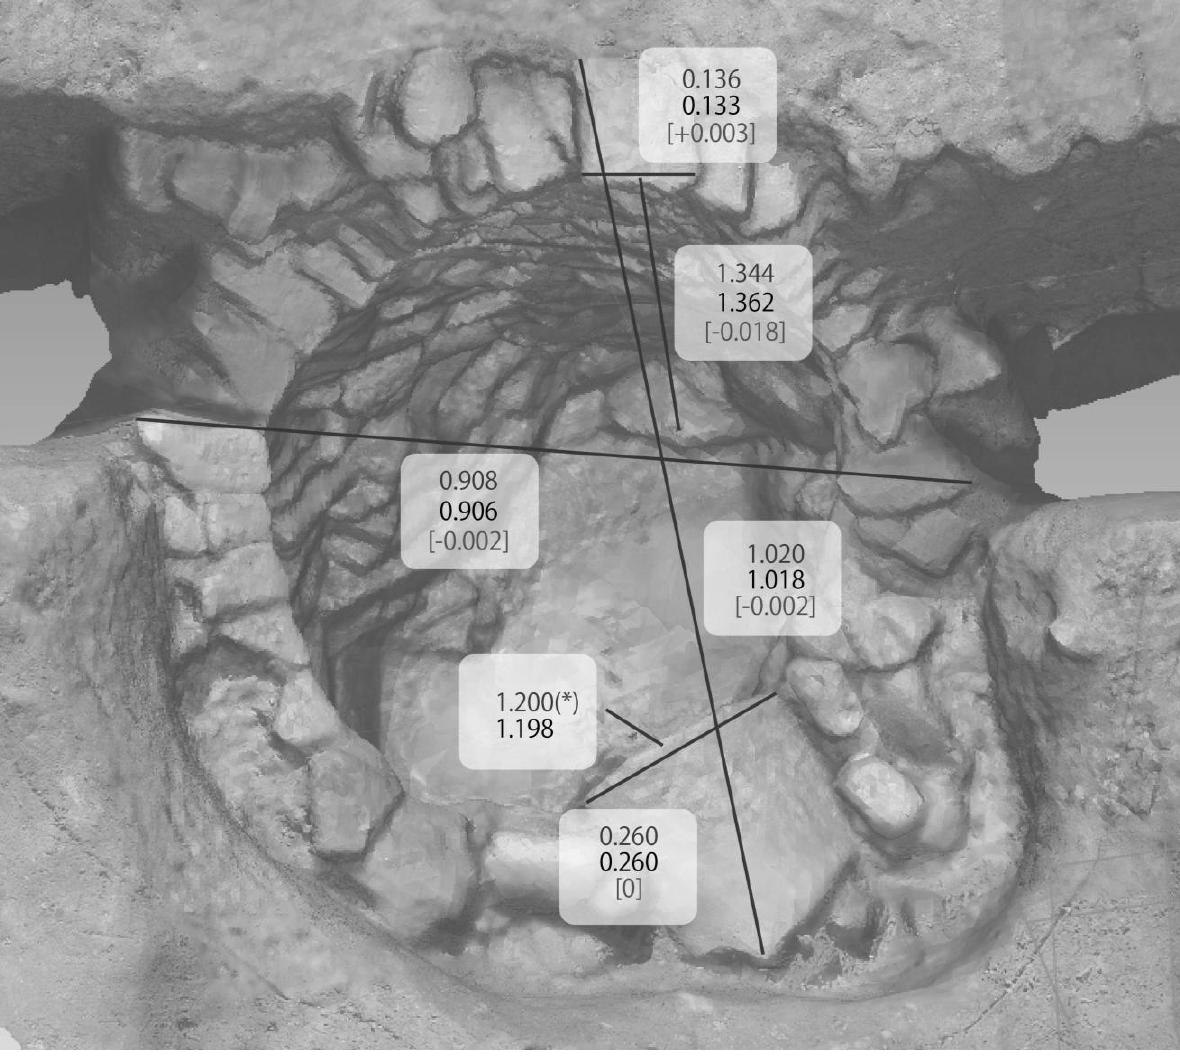
Figure 3. A comparison of actual length and SfM